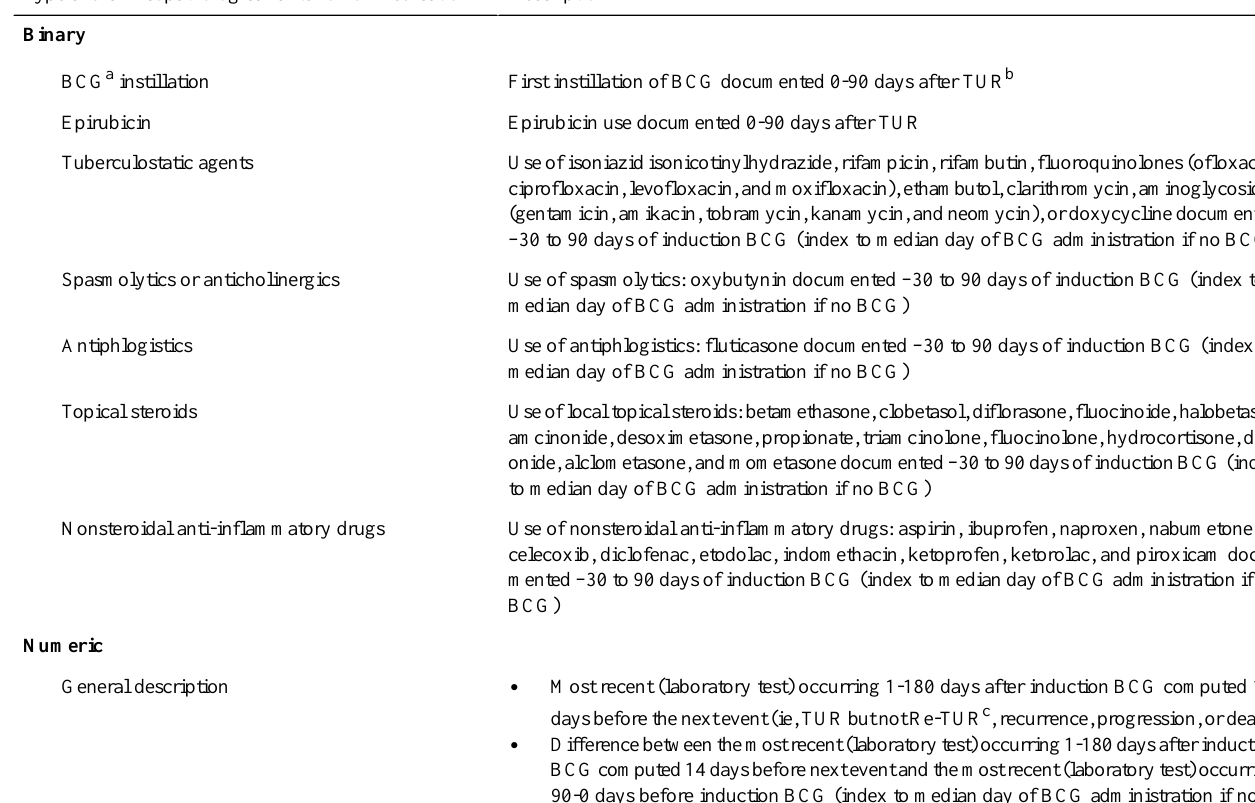
Table 1. Clinicopathological criteria or medication definitions. DescriptionType and clinicopathological criterion or